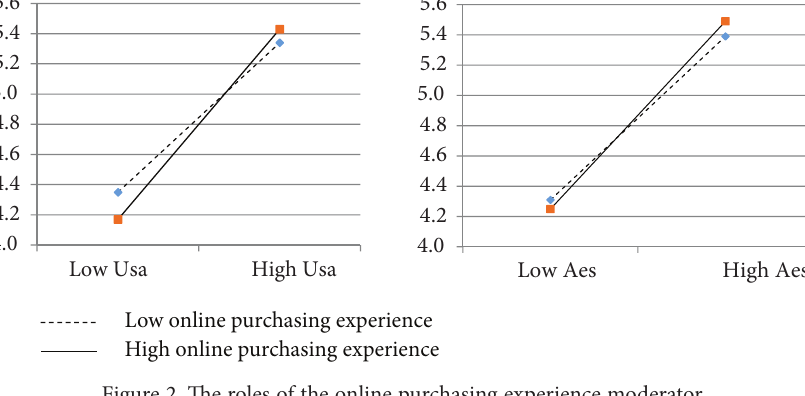
Figure 2. The roles of the online purchasing experience